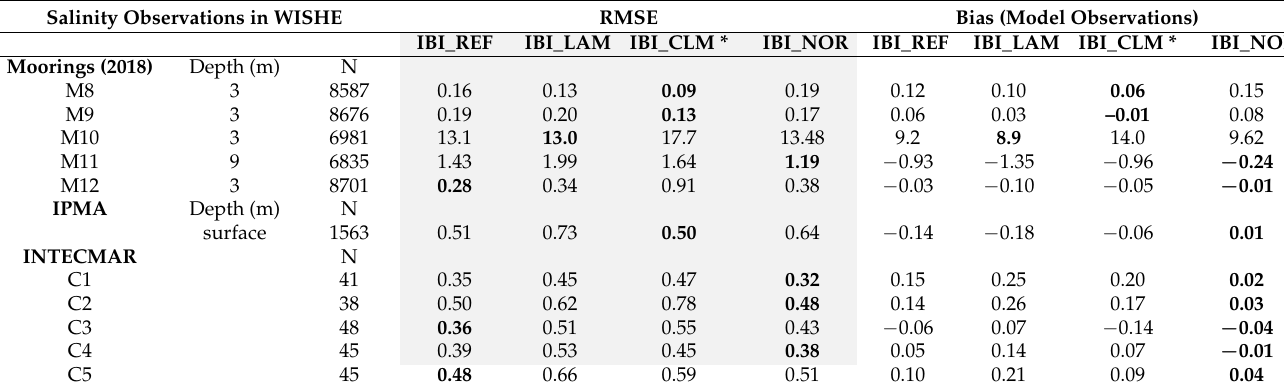
Table 6. Mean difference (Bias) and Root Mean Squared Error (RMSE) between observed salinity (from mooring buoys, an IPMA campaign with thermo-salinograph and INTECMAR CTD stations) and simulated one (from the IBI_REF, IBI_LAM, IBI_CLM, IBI_NOR model scenarios), over the respective length of the simulations, in the WISHE area. The smallest model bias and RMSE for each dataset are in bold. The mooring data have hourly frequency, the IPMA data was measured every 10 min and INTECMAR measurements at each CTD station have a weekly frequency. N is the number of measurements. Salinity Observations in WISHE